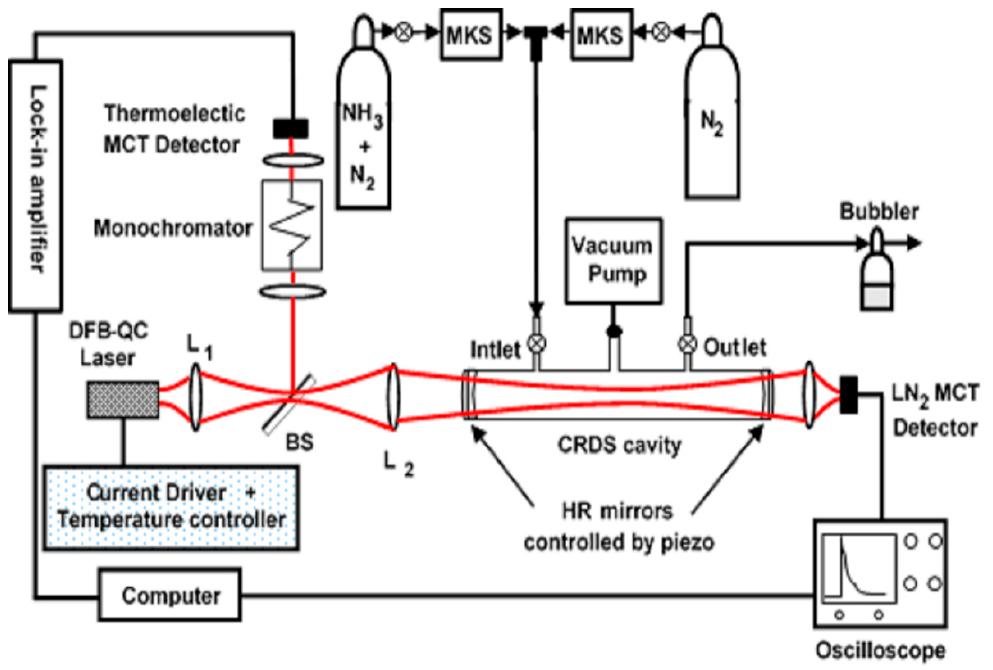
Figure 1. Schematic representation of the cavity ring-down spectrometer setup.